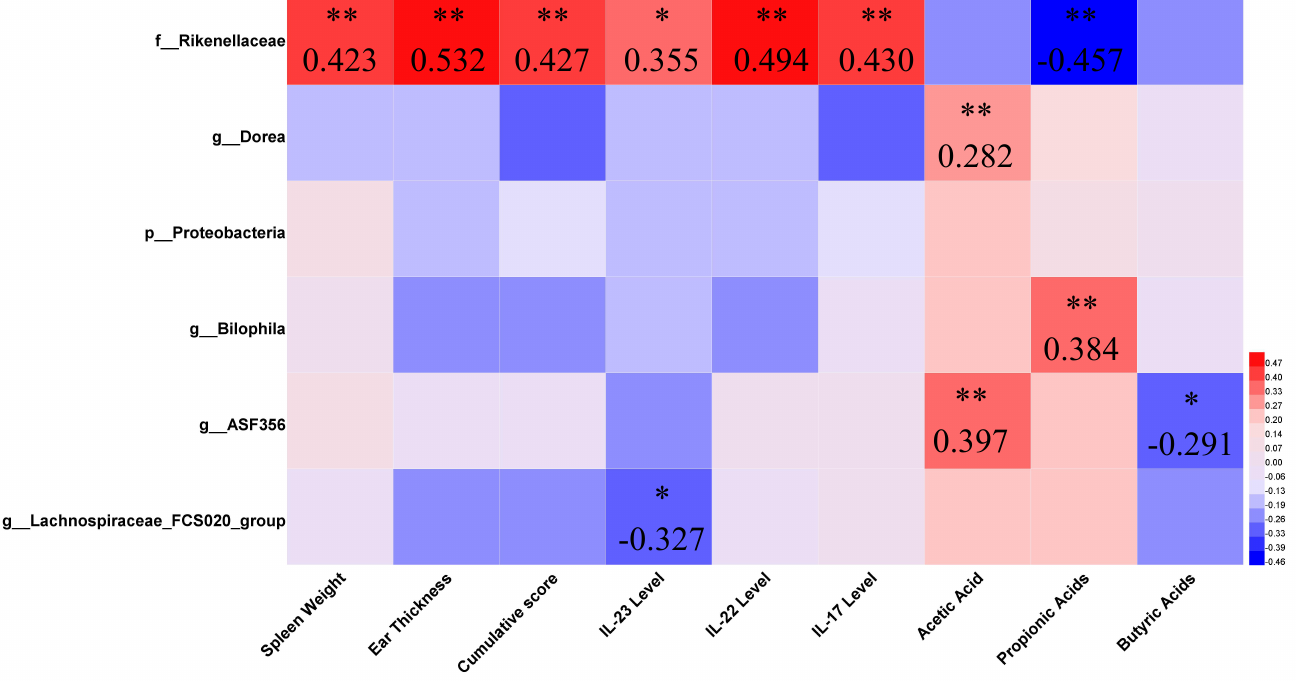
Figure 10. Spearman correlation analysis between the key gut microbiota and psoriasis-like pathological characteristics. * p < 0.05, ** p <